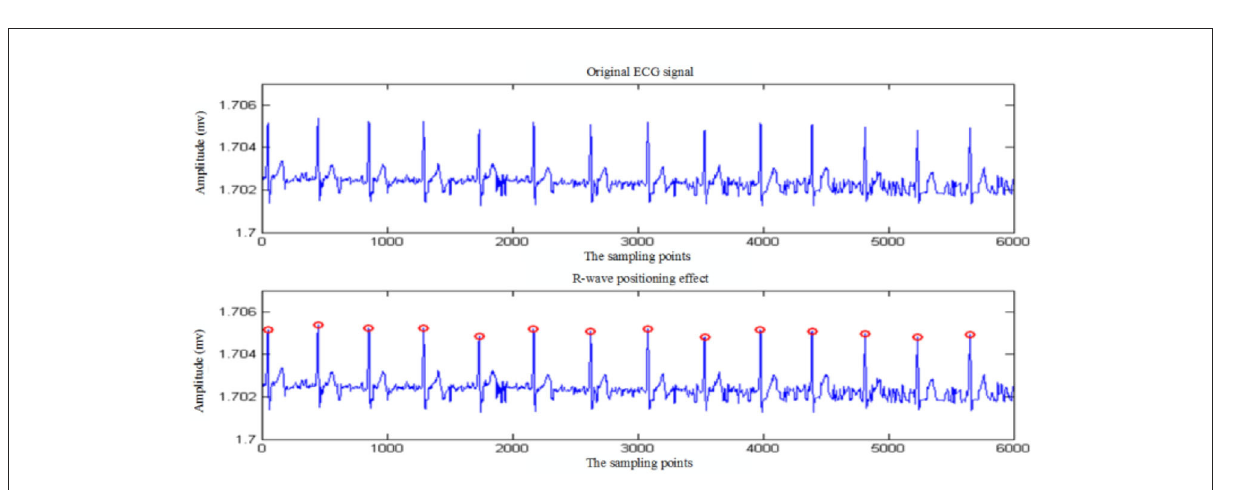
FIGURE9 R-wave detection of ECG signal with noise